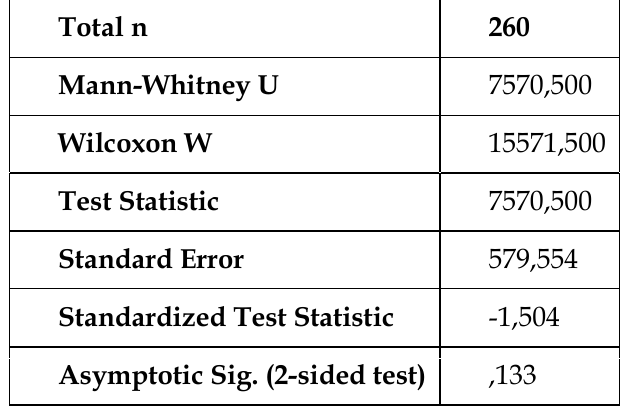
Table 34. Willingness to use the Digital Health Centre and gender. Mann-Whitney U Sig